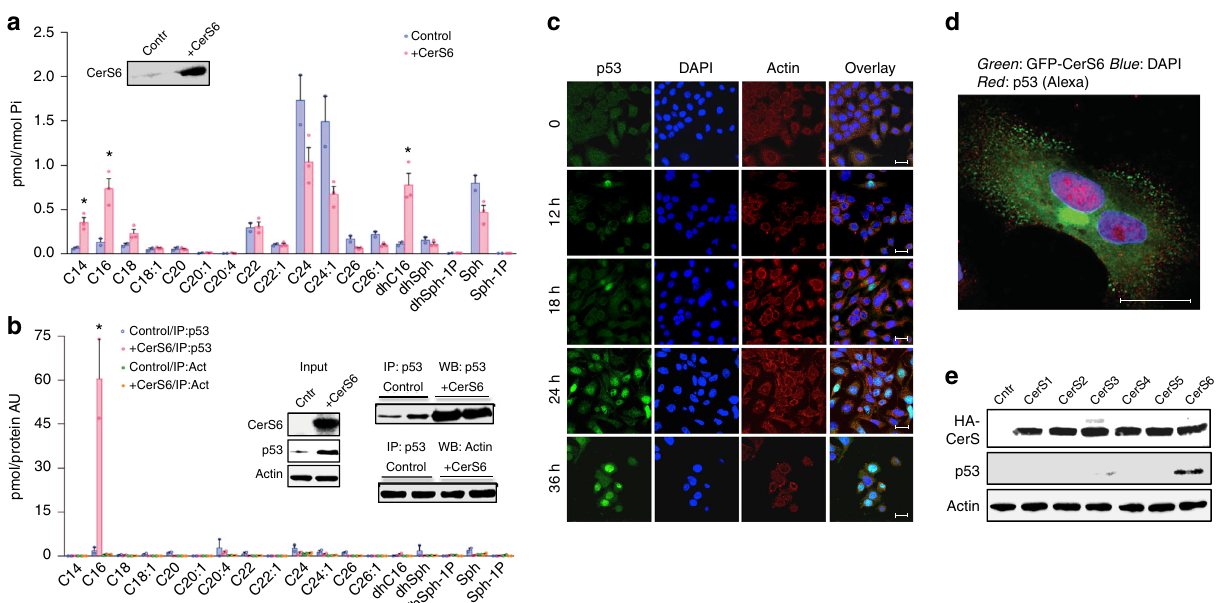
Fig. 5 p53 forms complex with natural C 16 -ceramide in the cell. a Levels of ceramide species in A549 cells after CerS6 transient transfection (36 h) or in non-transfected control cells (LC-MS/MS; mean ± SD; n = 2; * P < 0.0002, Student ’ s t test). b Ceramide levels (mean ± SD; n = 2; * P < 0.01, ANOVA) in p53 and actin fractions pulled down with corresponding antibodies from lysates of control or CerS6-transfected A549 cells. Lysates were divided into two portions, one was used for pull down with p53 speci fi c antibody and the other used for pull down with actin-speci fi c antibody (inset). Ceramide measurements were normalized to the amounts of speci fi c proteins in the pull downs. c Transient expression of CerS6 in A549 cells induces rapid accumulation of p53 and its nuclear translocation (green, p53; red, actin/cytoplasm; blue, DAPI/nuclei; scale bar represents 20 μ m). d Elevation of CerS6 in A549 cells (GFP-CerS6, green) leads to mostly nuclear localization of p53 (red); single cell image, scale bar represents 20 μ m. e Expression of CerS6 but not CerS1-5 induces p53 elevation in A549 cells 48 h